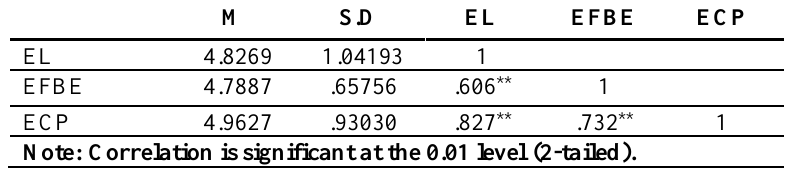
Table.1. Magnitude and Direction of Pearson